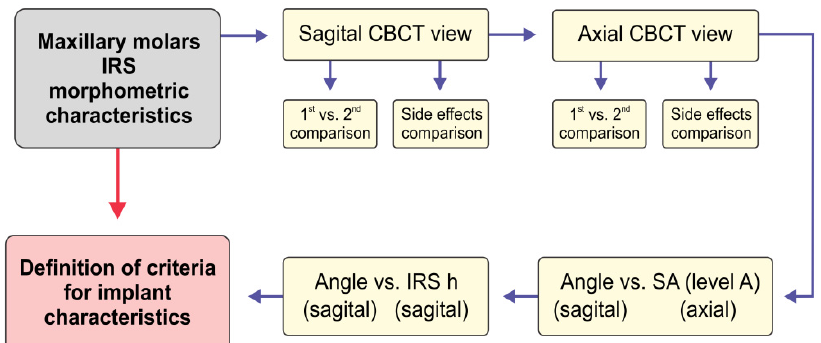
Figure 2. The scheme for the analysis of maxillary molars’ interradicular septum morphological characteristics as criteria for ideal immediate implant placement. The interradicular septum (IRS) parameters were used for the comparison between the first (1st) and second (2nd) and between the left and right (side effect) maxillary molars at different cross-sections of the sagittal and axial view. The interradicular furcation angle was then tested for the interconnection with the surface area (SA) at the level A, and IRS height (h).